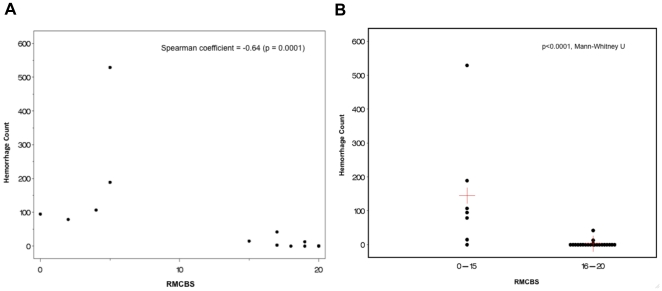
Correlation between RMCBS and number of hemorrhages.
A. Mice were serially sacrificed on days 2, 4, 6, 8, 9 and 10, demonstrating a strong negative correlation between the number of intracerebral hemorrhages and the RMCBS score on the day of sacrifice, r = −0.64 (p = 0.0001, experimental n = 22, control n = 6). B. Comparing the total number of hemorrhages in cohorts of mice that scored between 16–20 versus 0–15 (p<0.0001, Mann-Whitney U). Red crosshairs = mean RMCBS.